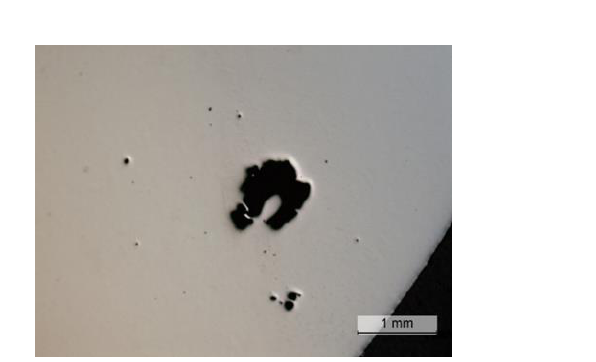
Figure 7. Porosities observed close to ( a ) and far ( b , c ) from the crack (marked by the arrows in picture ( a